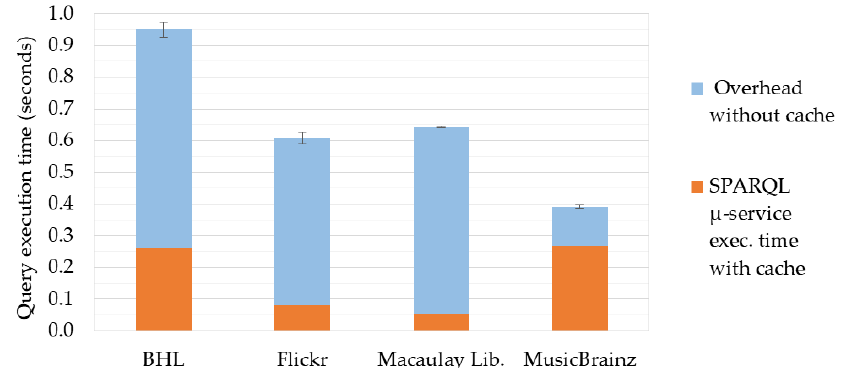
Figure 6. Impact of a cache database on the query execution time (in seconds) against a SPARQL